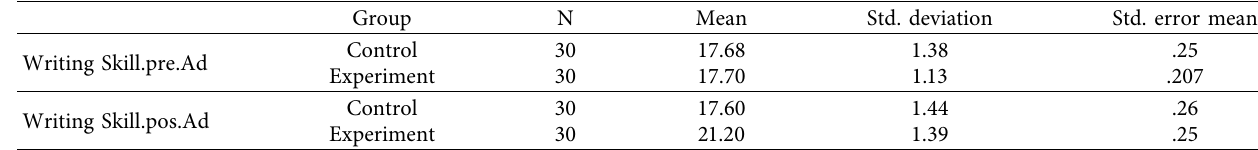
Table 20: Group statistics.